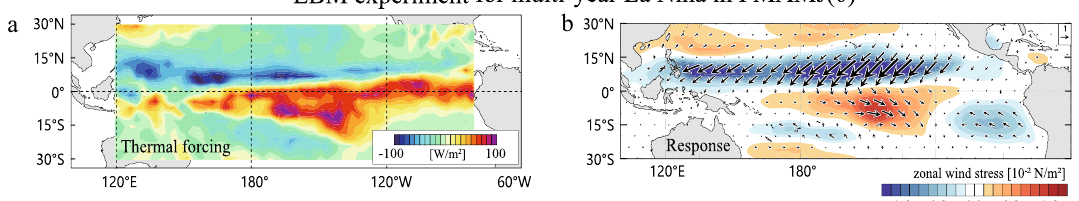
Figure 4. Diagnosing thermally forced steady linear response during FMAMJ(0) for multi-year La Niña. ( a ) Vertically integrated prescribed thermal forcing in multi-year La Niña composite (six events mean). Forcing is assumed to be zero outside of the tropical Pacific. ( b ) Steady response in the LBM (Methods) of surface zonal wind stress (shading) and wind stresses (vector: unit in 10 −2 N/m 2 ) forced by the diabatic heating shown in ( a ). (Maps are generated by visualize module PyNGL with Python Programming Language version 3.7; https:// www. pyngl. ucar.